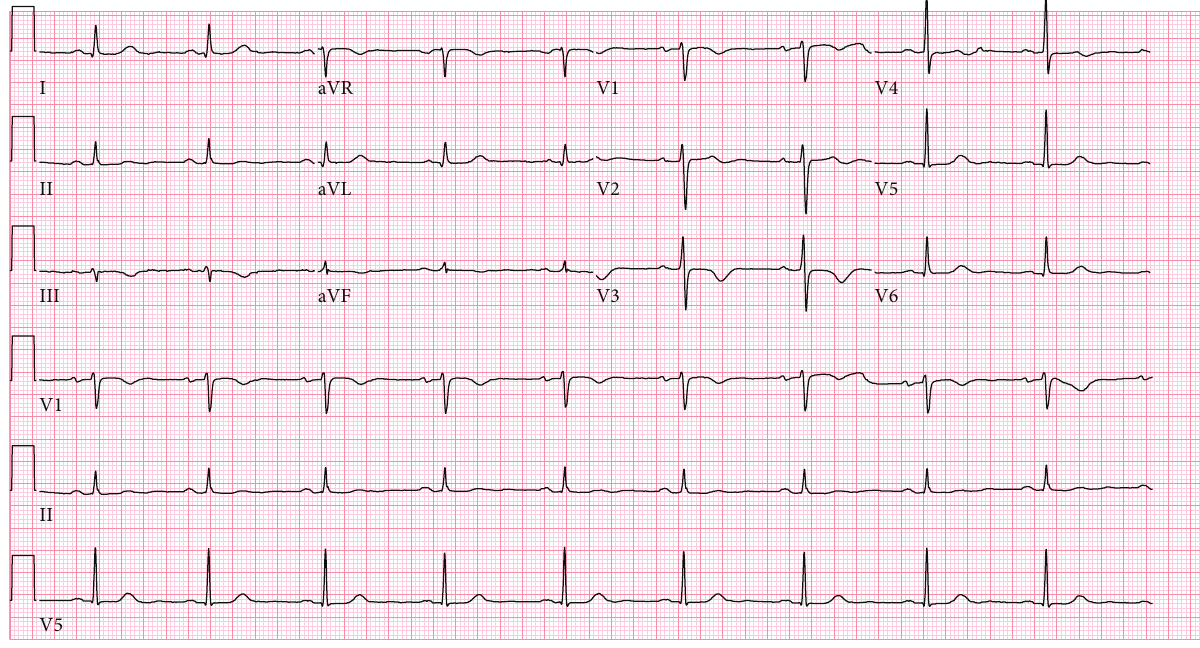
Figure 6: Electrocardiogram. Showing nonspecific T wave abnormalities.